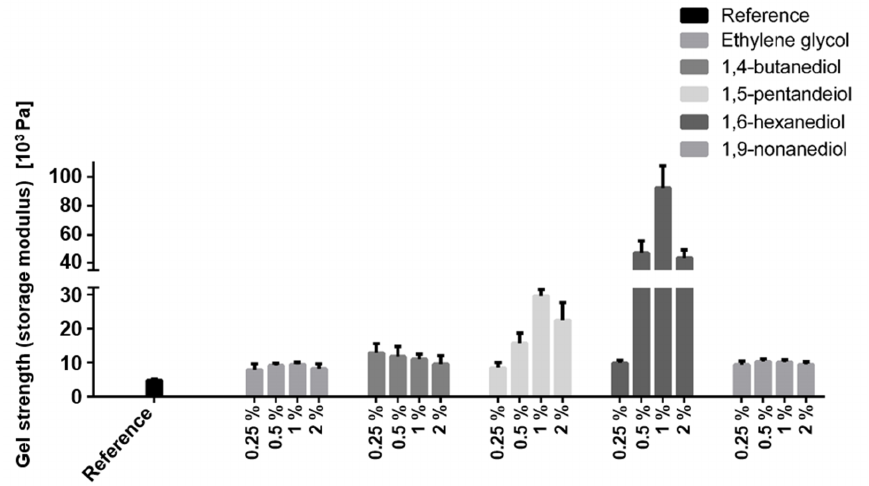
Figure 7. Gel strength of oleogels (8%) with terminal diols in a concentration range of 0.25–2%; an oleogel without any additive serves as a reference; mean ± SD, n =